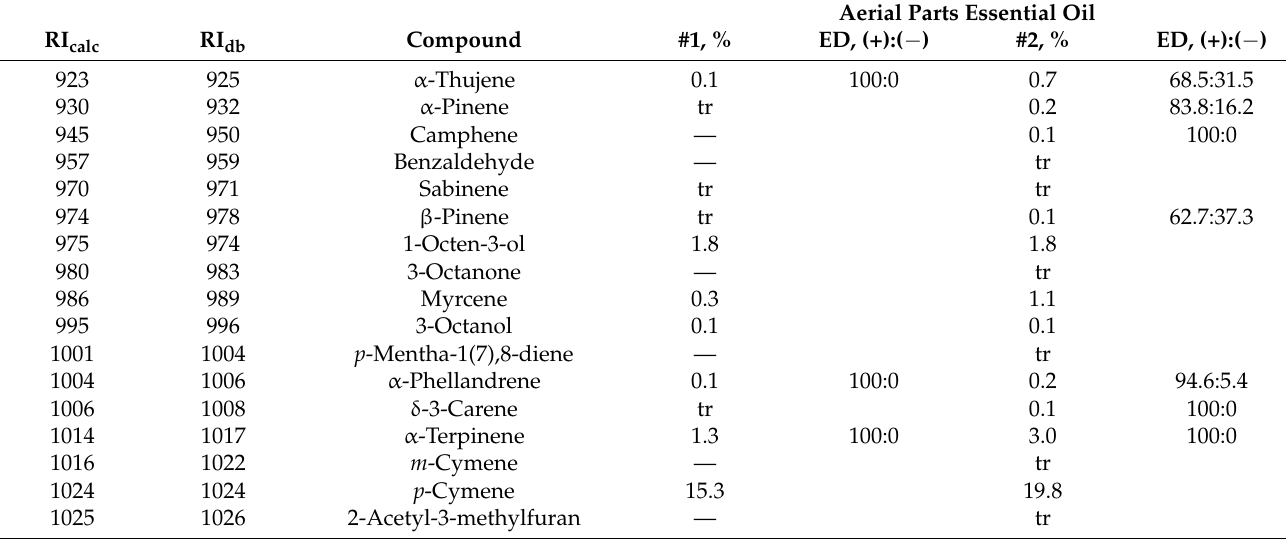
Table 3. Chemical composition of Monarda punctata essential oils growing wild in south Alabama.